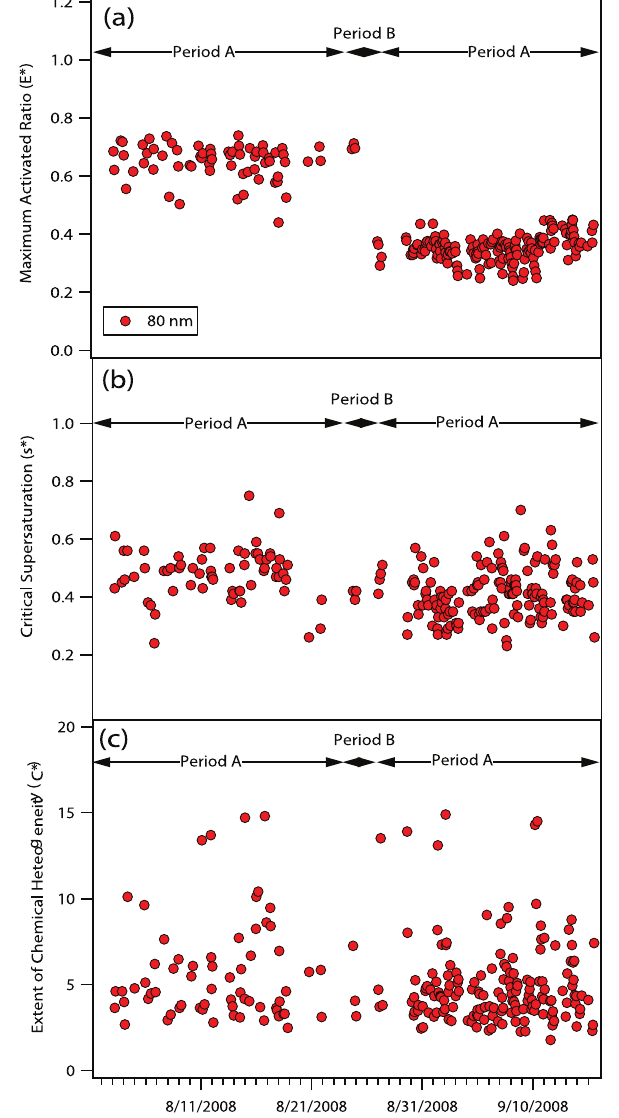
Fig. 10. Time-series of (a) maximum activated ratio, (b) characteris- tic critical supersaturation, and (c) extent of chemical heterogeneity for 80nm particles. Period A correspond to air masses originating from the continental US; while period B corresponds to air masses originating from either the Atlantic Ocean or Gulf of Mexico.